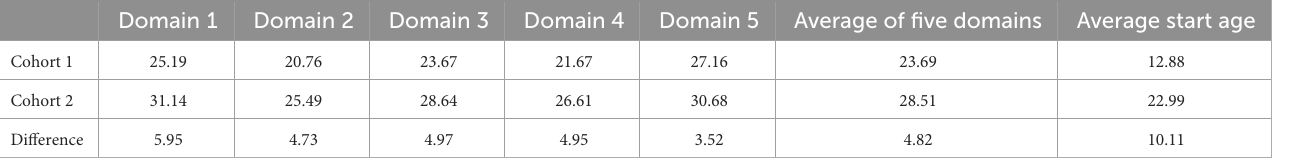
TABLE 4 The average observation ages (in the month) in each domain of two cohorts.